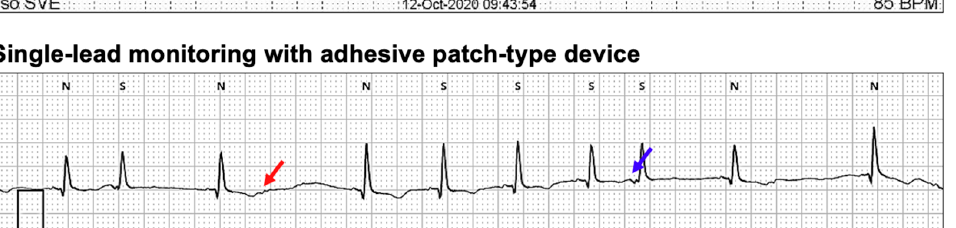
Figure 5. An exemplary case of reporting more SVEBs with a single-lead ECG monitoring than with Holter monitoring. In this participant, non-conducted PACs (red arrows) and conducted PACs (blue arrows) were observed in Holter monitoring, whereas P-waves were rarely visible with the single-lead monitoring. Compared to the sinus rhythm, the P-wave morphology was different in non-conducted and conducted PACs in Holter monitoring. Therefore, detecting SVEBs with single-lead monitoring mostly depends on evaluating RR intervals and QRS morphology. As a result, SVEBs may be overestimated with the single-lead monitoring than with Holter for this case. Abbreviations: ECG, electrocardiogram; PAC, premature atrial complex; SVEB, supraventricular ectopic